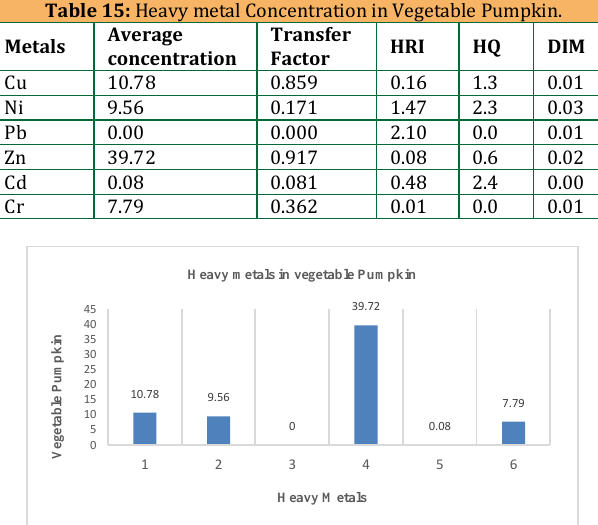
Table 15: Heavy metal Concentration in Vegetable Pumpkin.